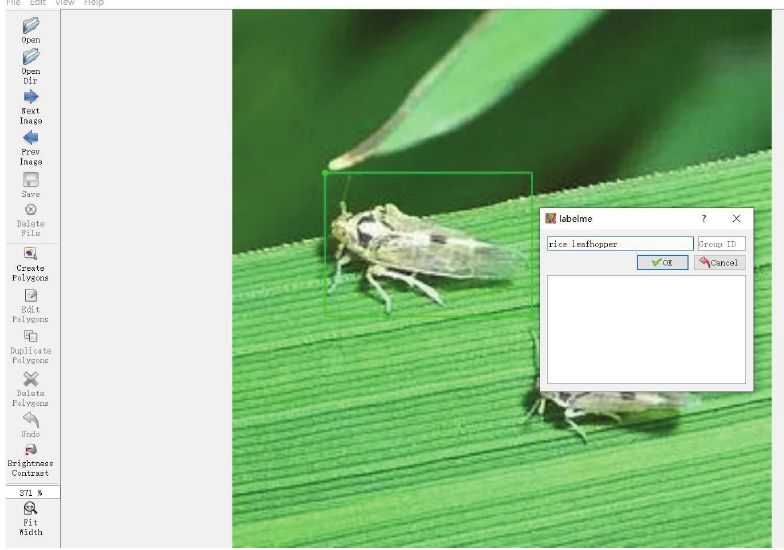
Figure 6. We adopt Labelme to annotate each insect pest in an image by marking a